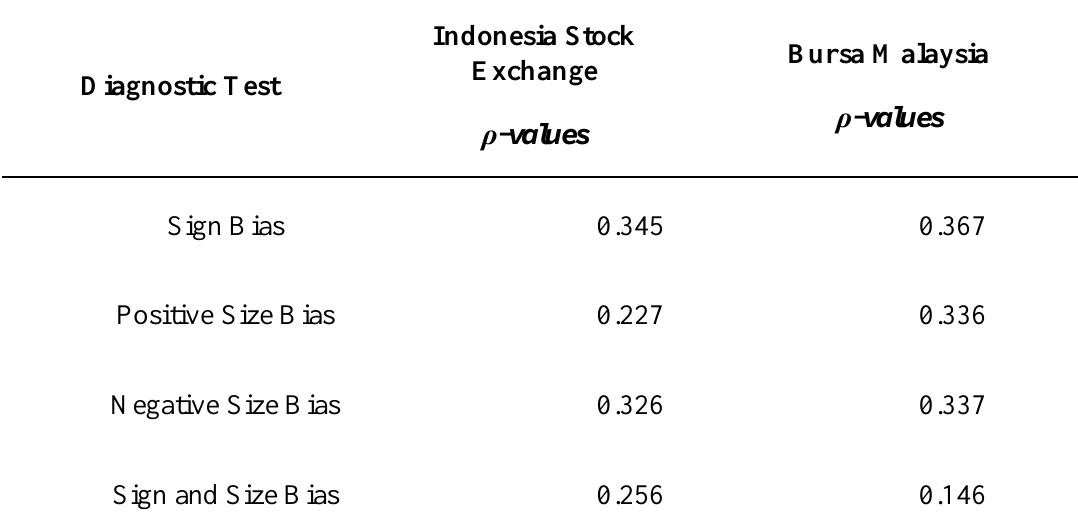
Table 7. Asymmetry Test